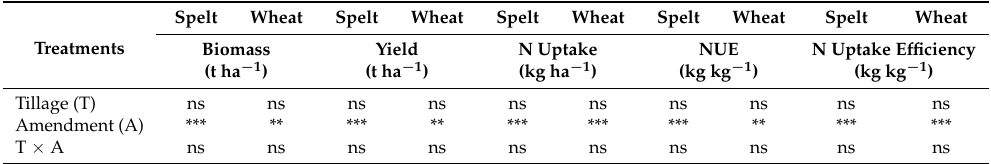
Table 1. Analysis of variance for the effect of tillage system and organic amendment on biomass (dry matter), yield, and N efficiency parameters of spelt and wheat crops. NUE = N utilization efficiency